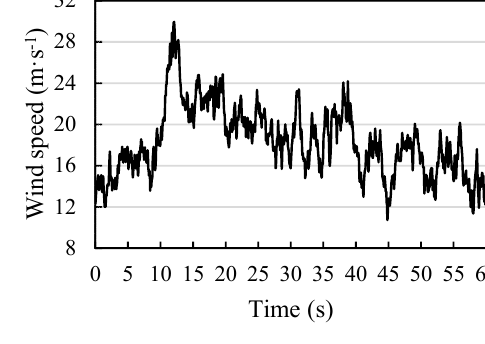
Figure 6. Longitudinal wind speed.